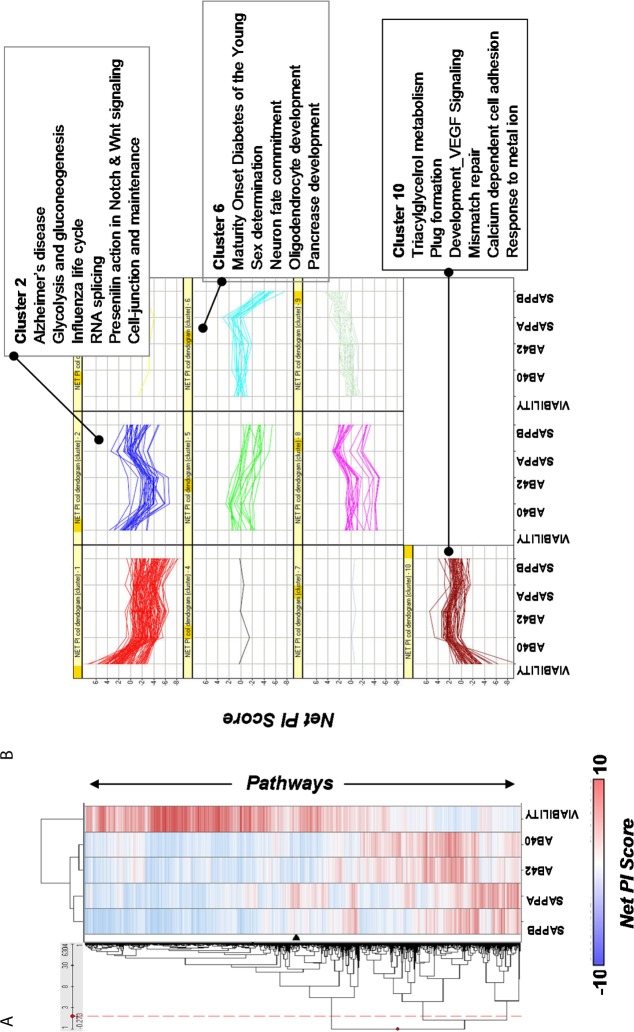
Differential effects of pathways on different readouts.Not all pathways, if knocked down by siRNA, affect biological endpoints in the same manner. A. The dendrogram on the left represents hierarchical clustering of pathways across different readouts using their Net PI score. Each row corresponds to a pathway. Blue: negative PI score (readout decreased). Red: positive PI score (readout increased). B. Individual pathway/process profiles across the readouts for each cluster. This representation allows one to identify pathways/processes that may have favourable profiles (lower net levels of amyloidogenic peptides), such as Cluster 2 and Cluster 6, and those with undesirable profiles (greater net levels of amyloidogenic peptides), such as Cluster 10. Cluster 2 and Cluster 6 show reduction in the amyloidogenic peptides Aβ40, Aβ42, and sAPPβ, with increases in sAPPα (β-secretase-inhibition profile) and no net decrease in viability. Conversely, Cluster 10 pathways have strong net decreases in viability and net increases in amyloidogenic peptides, and hence could be potentially considered pathological.